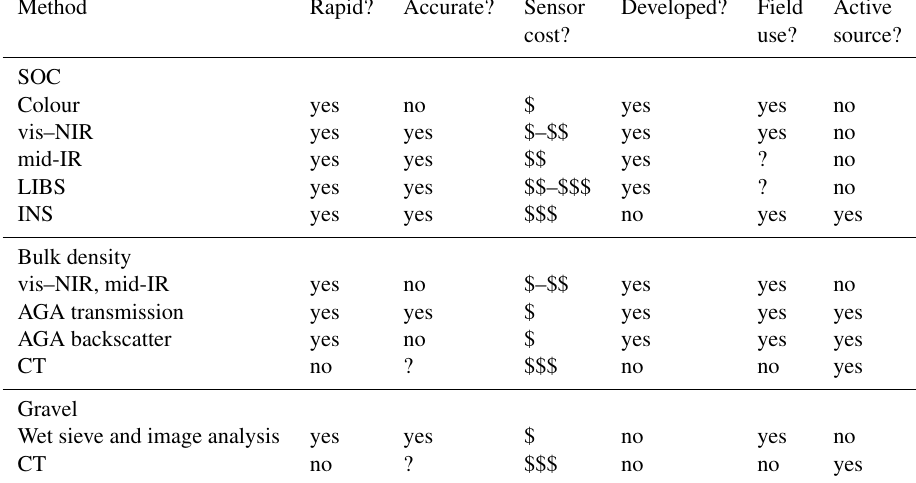
Table 2. Assessment of proximal sensing technologies regarding their readiness to underpin carbon accounting methodologies. The sensing methods are visible–near-infrared (vis–NIR) and mid-infrared (mid-IR) diffuse reflectance spectroscopy; laser-induced breakdown spec- troscopy (LIBS); inelastic neutron scattering (INS); active gamma-ray attenuation (AGA); gamma- and X-ray computed tomography (CT). A “?” indicates “unknown” or “not sufficiently developed”; accuracy is relative to the conventional dry-combustion method for soil or- ganic C concentration, volumetric ring method for bulk density, and manual processing for gravel content; cost: $ – AUD0–40000; $$